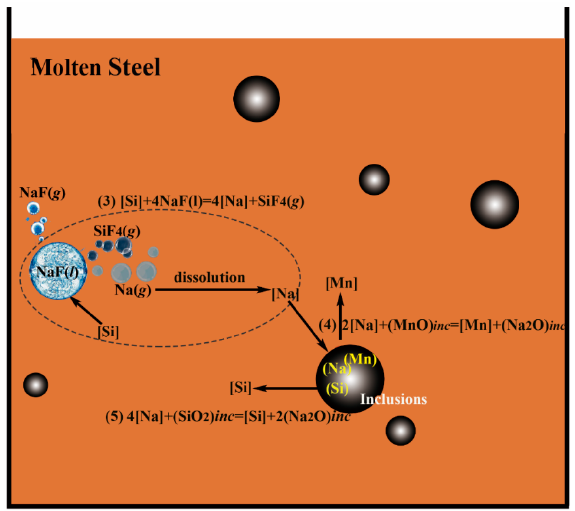
Figure 10. Schematic diagram of inclusion modification by NaF treatment.